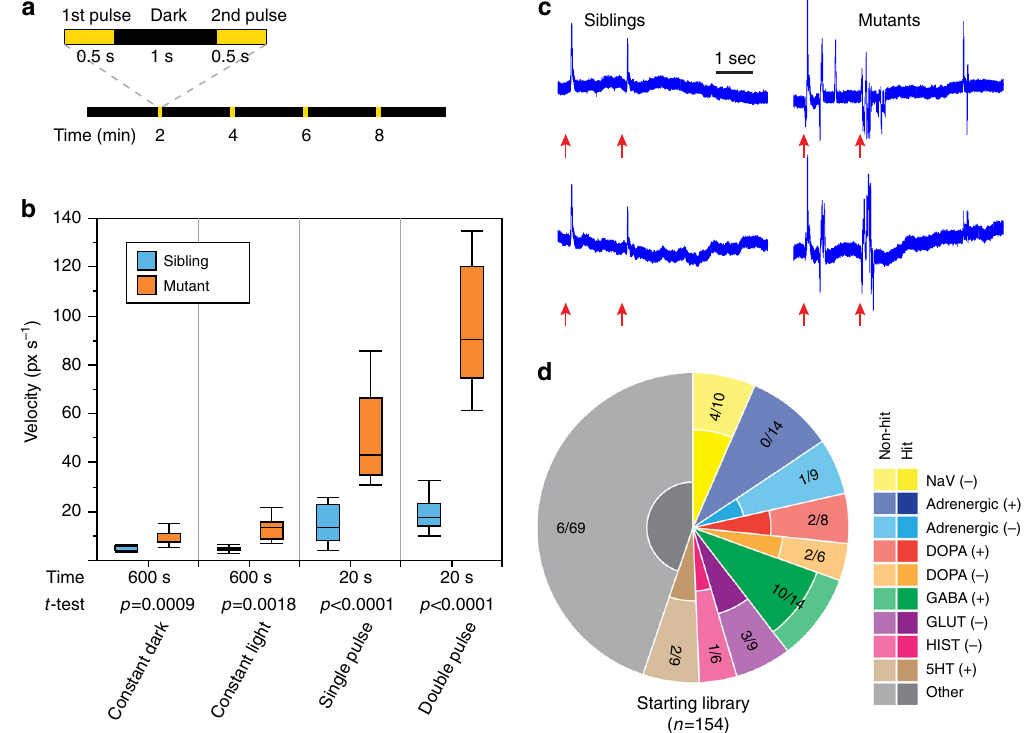
Fig. 1 Light-induced seizures enable high-throughput screening in zebra fi sh larvae with scn1lab mutations. a Schematic representation of light stimulus parameters. Light stimuli are applied every 2 min in an otherwise dark environment. Each stimulus consists of two consecutive 500 ms light pulses separated by 1 s of dark. b Box-and-whisker plots showing mean swimming velocity in scn1lab s552 homozygous mutants (orange) and age-matched sibling controls (blue). 12 siblings and 12 mutants are used per condition. For constant dark and constant light conditions, mean swimming velocities are calculated over a full 10 min recording session. For light-triggered activity, velocities are calculated during 5 s intervals following the onset of each stimulus, resulting in a total assay time of 20 s. Tops and bottoms of each box represent the 1st and 3rd quartiles. Whiskers are drawn from the ends of the interquartile ranges (IQR) to the outermost data point that falls within ± 1.5 times the IQR. The line in the middle of each box is the sample median. Statistical signi fi cance was determined by Welch ’ s t -test. c Representative local fi eld potential (LFP) recordings from the forebrains of scn1lab s552 homozygous mutant larvae and age-matched sibling controls at 7 dpf in response to light stimuli. Red arrows indicate the onset of the two 500 ms light pulses.